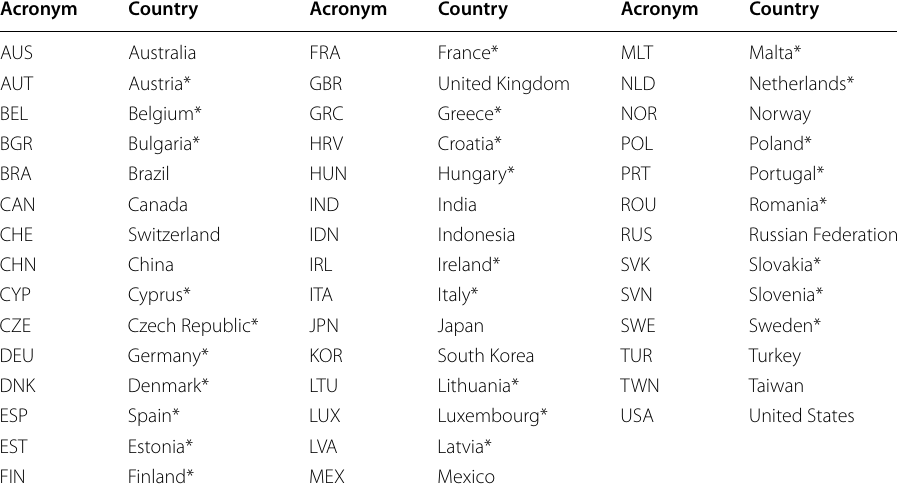
Table 4 Countries in the World Input–Output